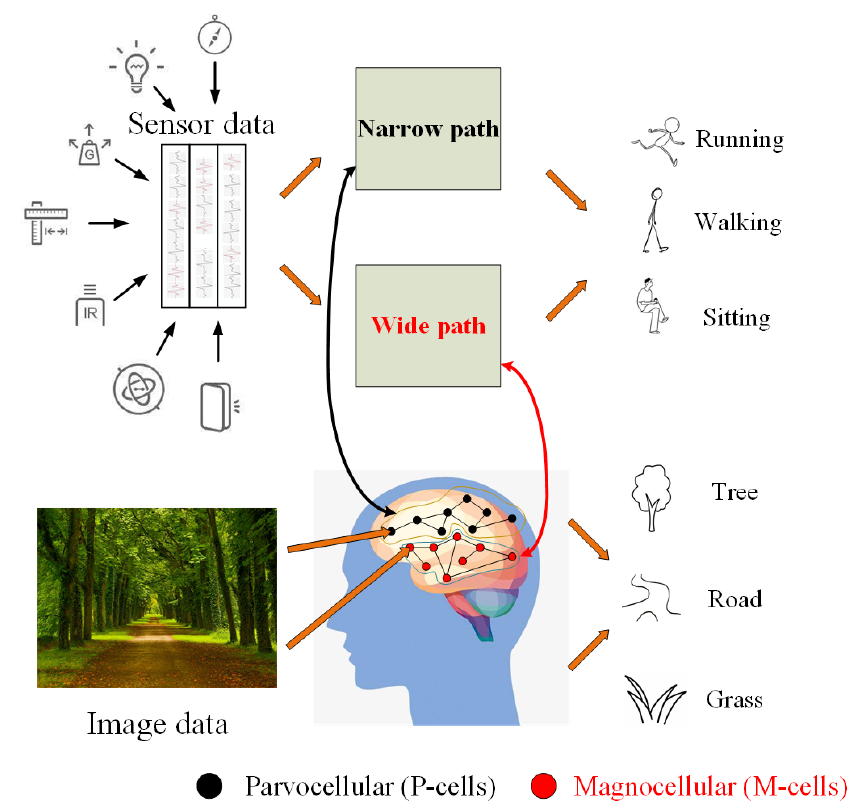
Figure 1. The basic motivation source of our proposed asymmetric residual network